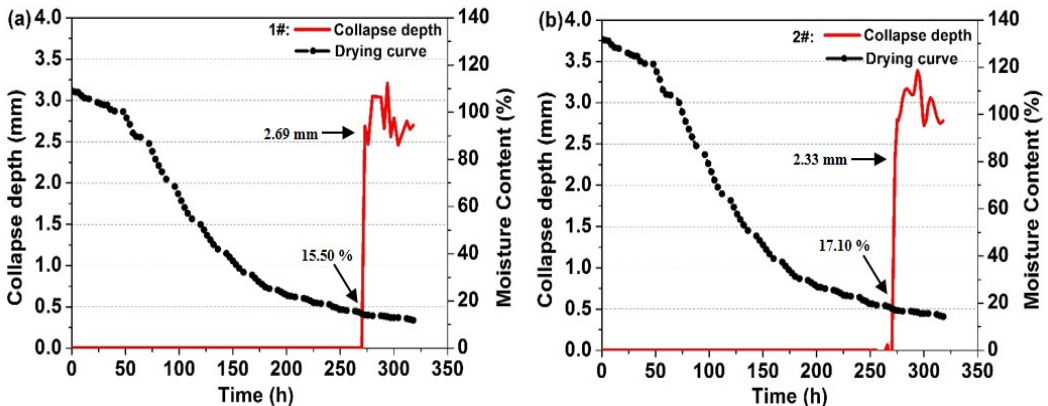
Figure 9. Collapse depth of T3 during drying. 1# collapse-depth curve of T3 ( a ); 2# collapse-depth curve of T3 ( b ).